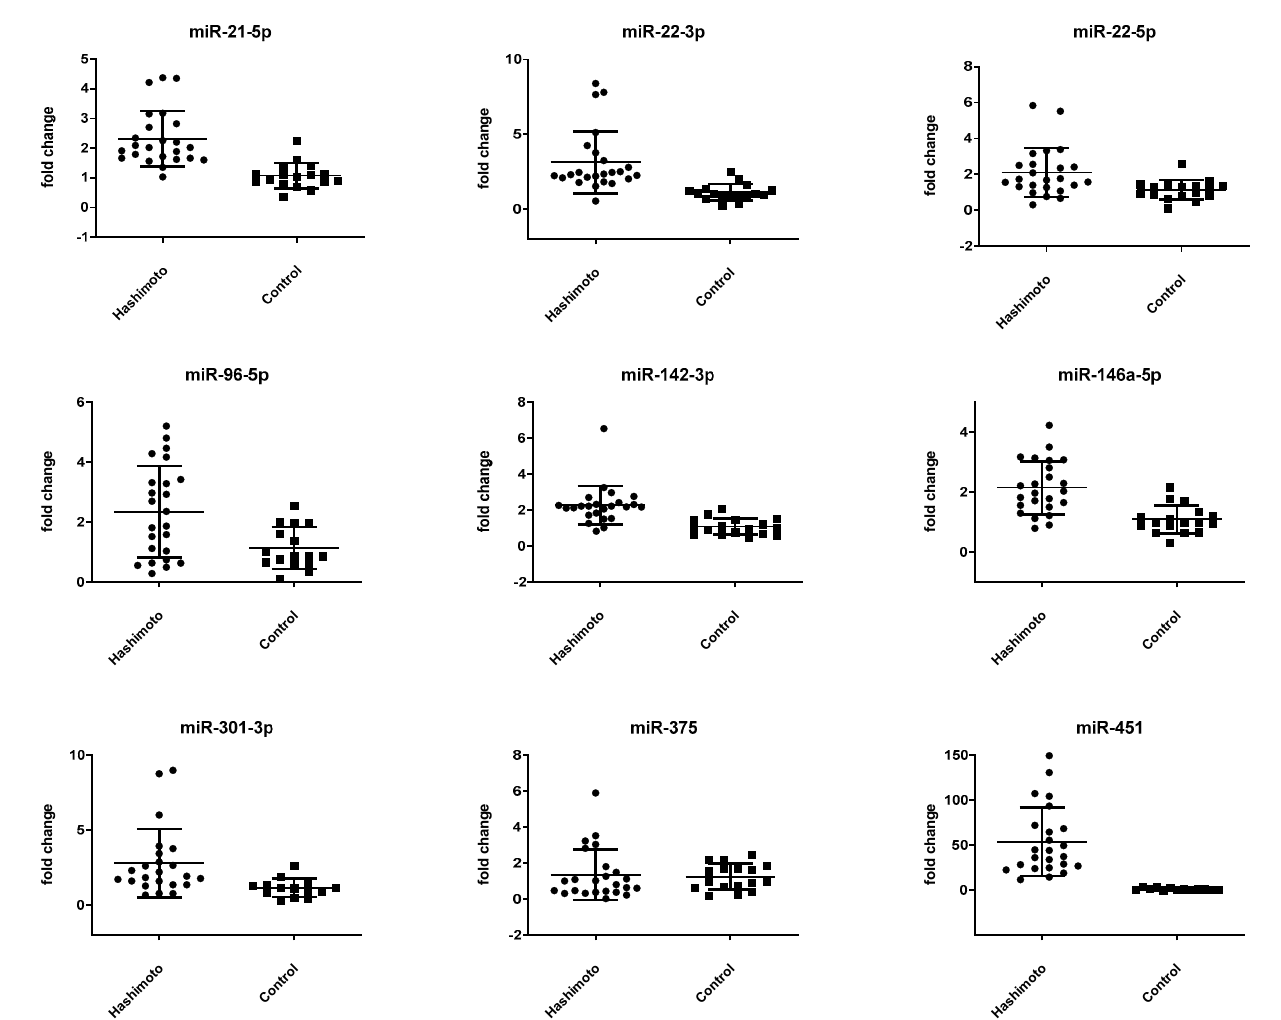
Figure 2. Expression of 9 miRNAs in serum of samples of HT patients and healthy controls. Data are displayed as scatter plots, where each dot represents the fold change as 2 − ∆∆ ct -value of one study sample. Significance was tested by unpaired Student’s t -test.